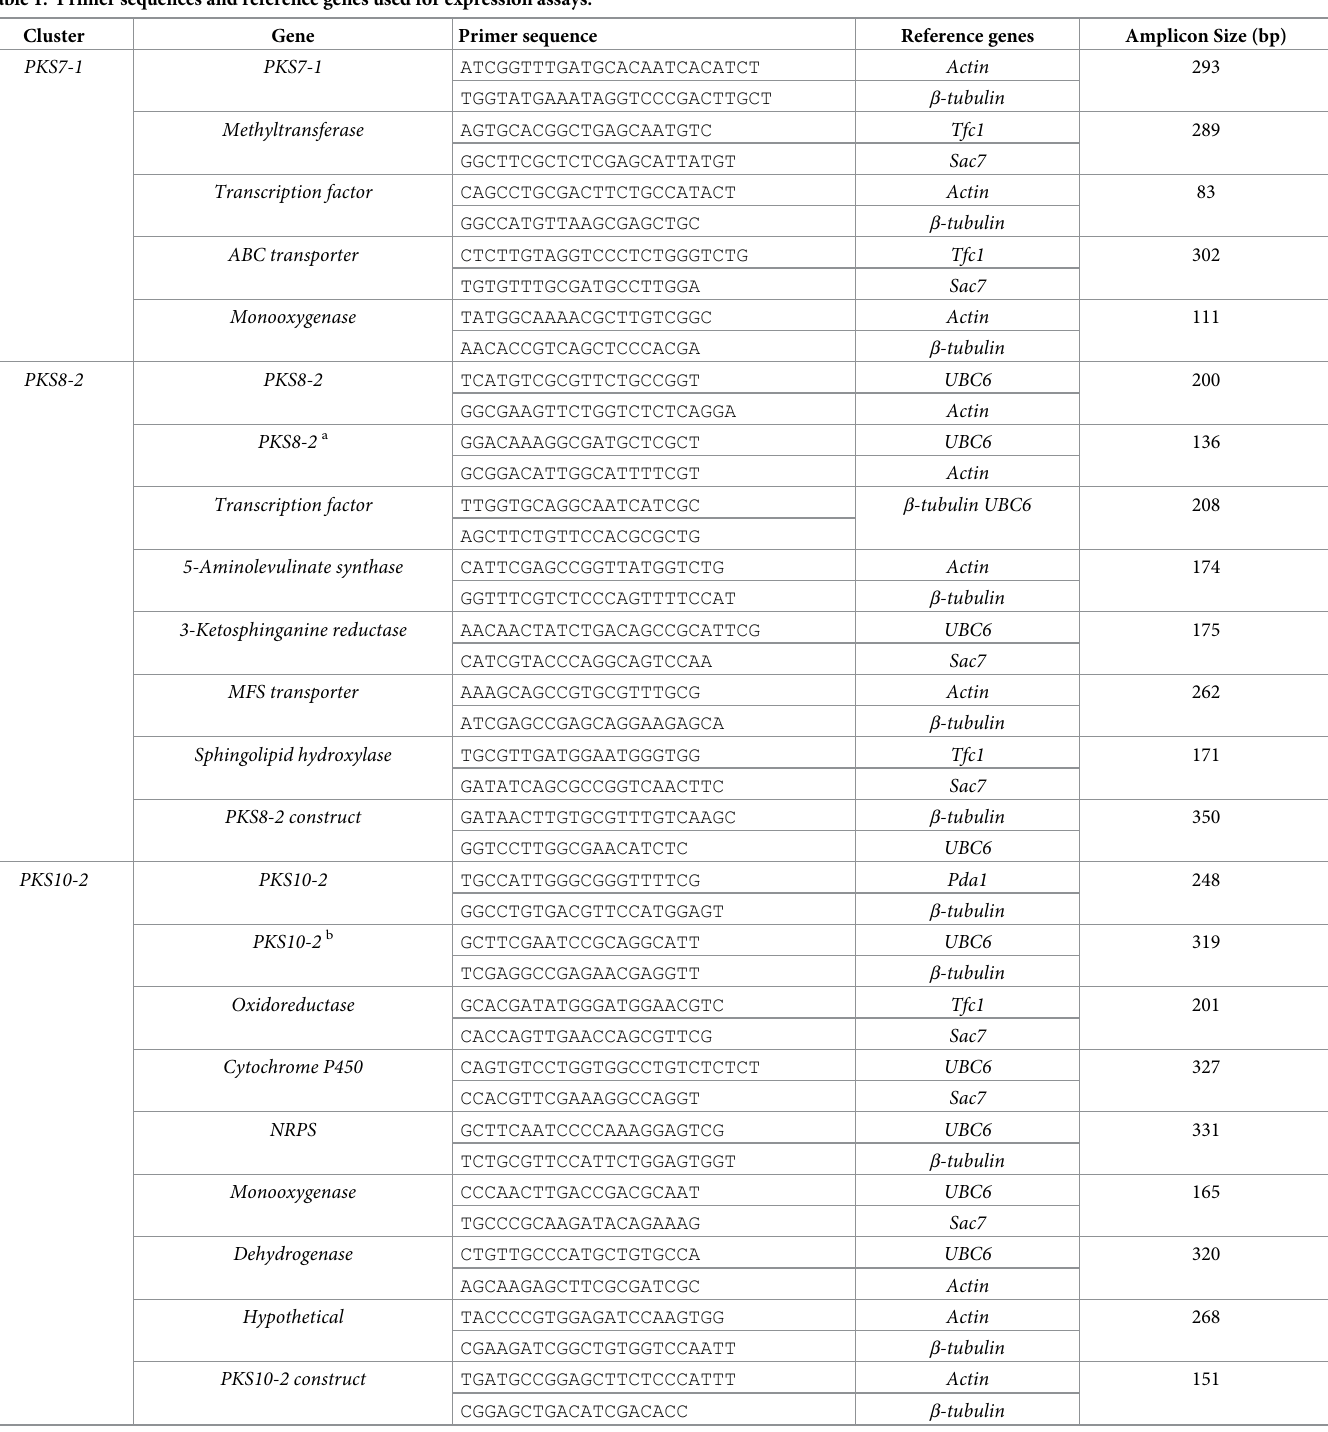
Table 1. Primer sequences and reference genes used for expression